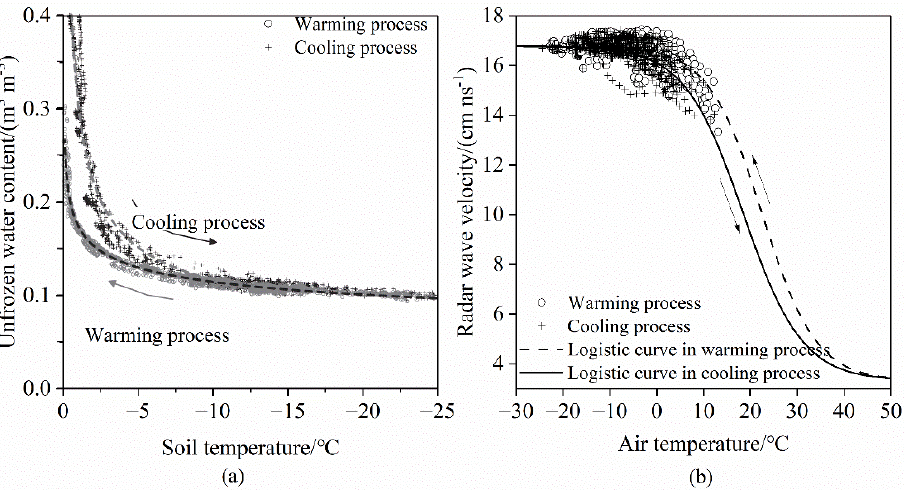
Figure 8. Physical and mathematical basis for selecting Equation (6). ( a ) Unfrozen water content in frozen soil changing with soil temperature in warming and cooling process (modified from Ref. [40]) ( b ) schematic diagram of logistic model of radar wave velocity in Yellow River ice changing with air temperature.